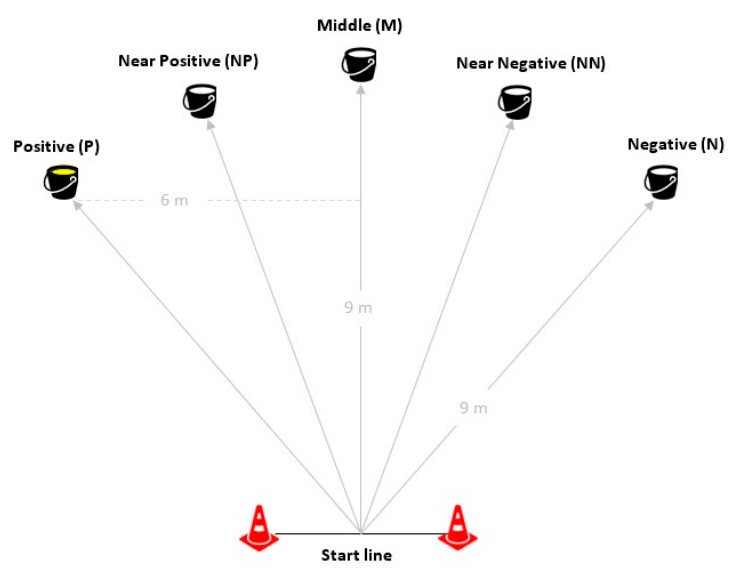
Figure 1. The setting of the spatial judgement test. P is the Positive position (bucket with food) and N is the Negative position (empty bucket). The ambiguous positions (empty bucket) are Near Positive (NP), Middle (M), and Near Negative (NN).